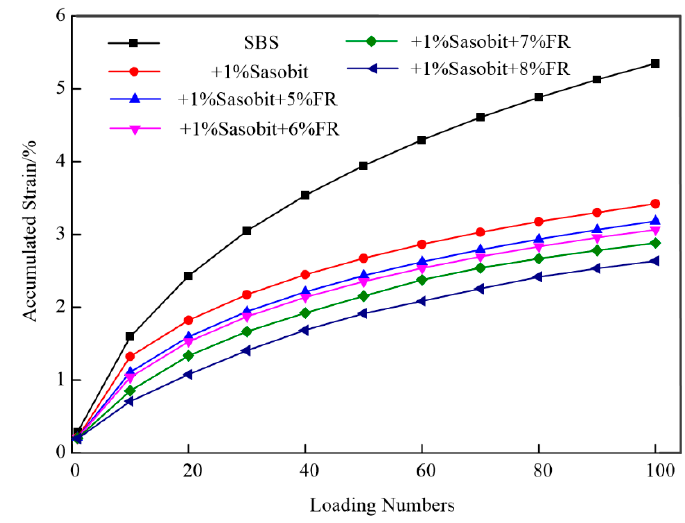
Figure 10. The relationship between loading numbers and cumulative strain at 40 °C.